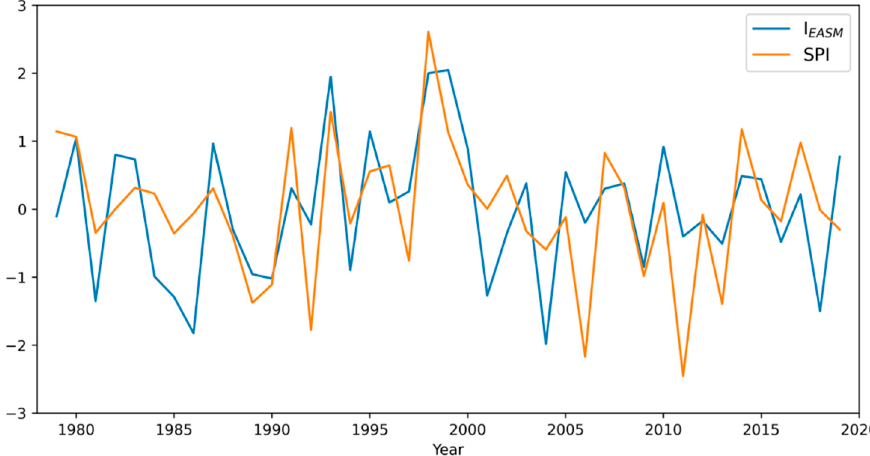
Figure 6. Sequences of both the East Asian subtropical monsoon surge intensity and the standardized index of summer precipitation in southwest China, for the period